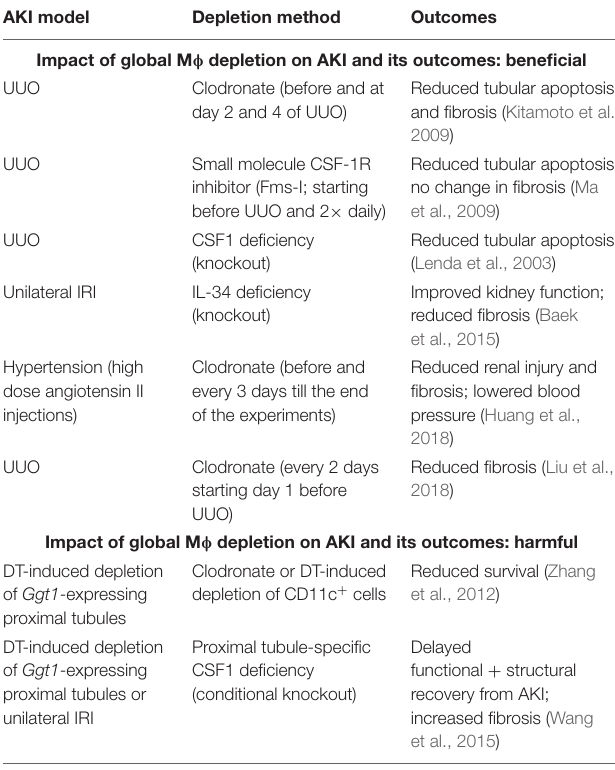
TABLE 1 | Impact of global M φ depletion on AKI and its